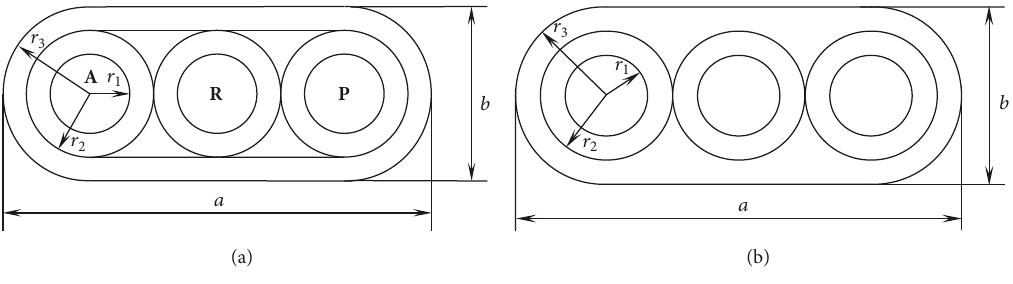
Figure 6: Cross section of cables with (a) and without (b) air